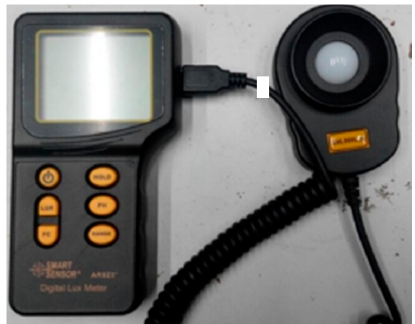
Figure 4. Arrangement of lamps.